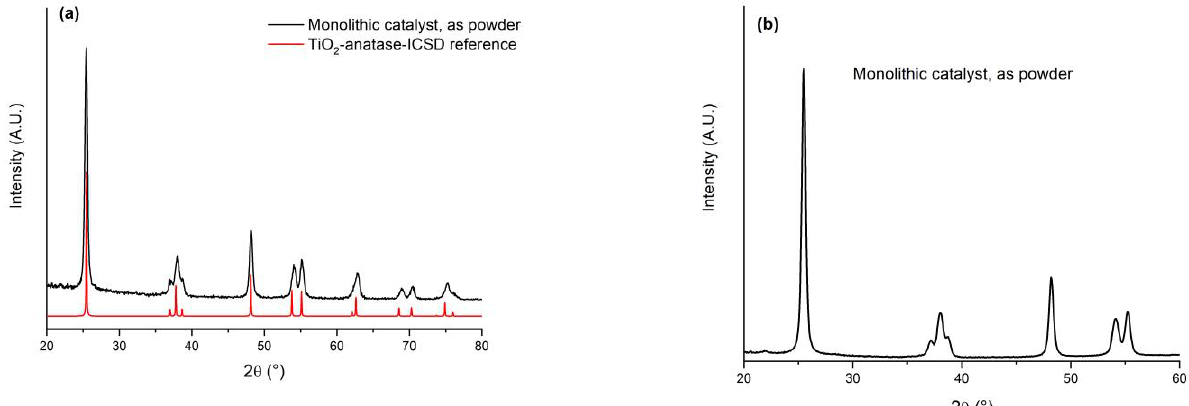
Figure 3. XRD patterns of the monolithic catalyst (as a powder) registered with different acquisition times: ( a ) 20 s/step; ( b ) 200 s/step. The TiO 2 anatase ICSD reference is plotted for comparison.